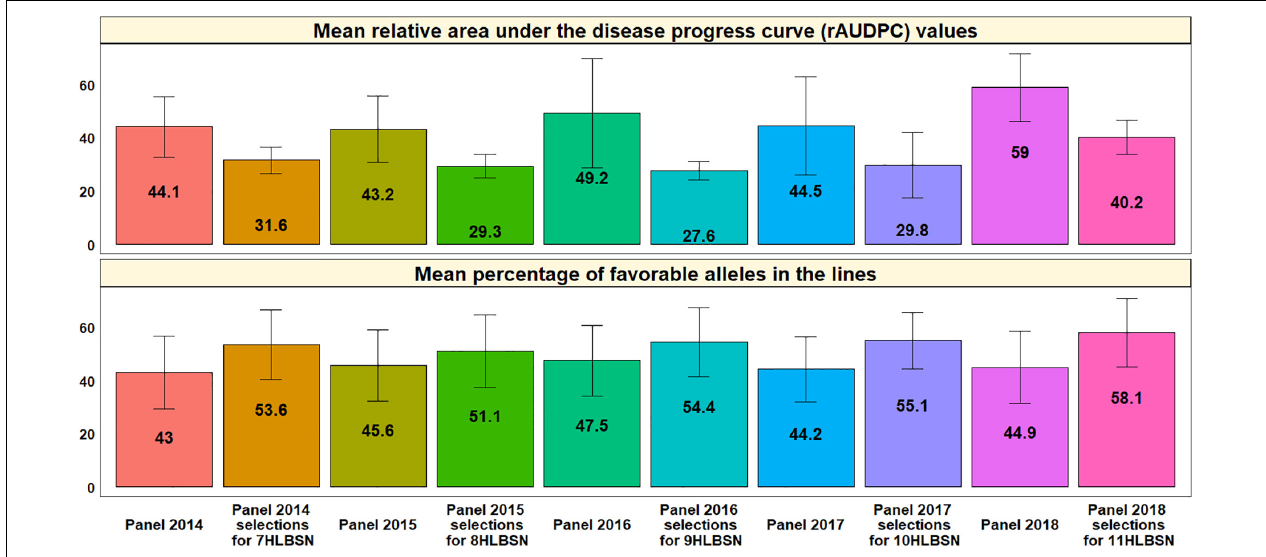
FIGURE 8 | Mean relative area under the disease progress curve (rAUDPC) values and mean percentage of favorable alleles in the lines from the different panels and selections from the panels that constitute the Helminthosporium Leaf Blight Screening Nurseries